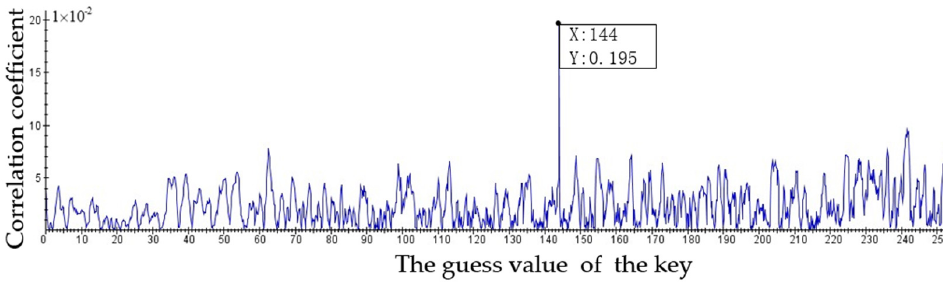
Figure 6. The third byte of 1 V CPA attack result.